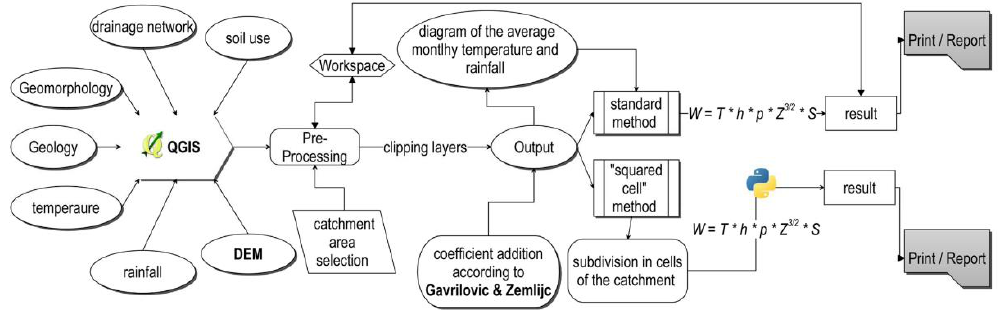
Figure 1. Flowchart summarizing all the operations carried out by the plug-in.